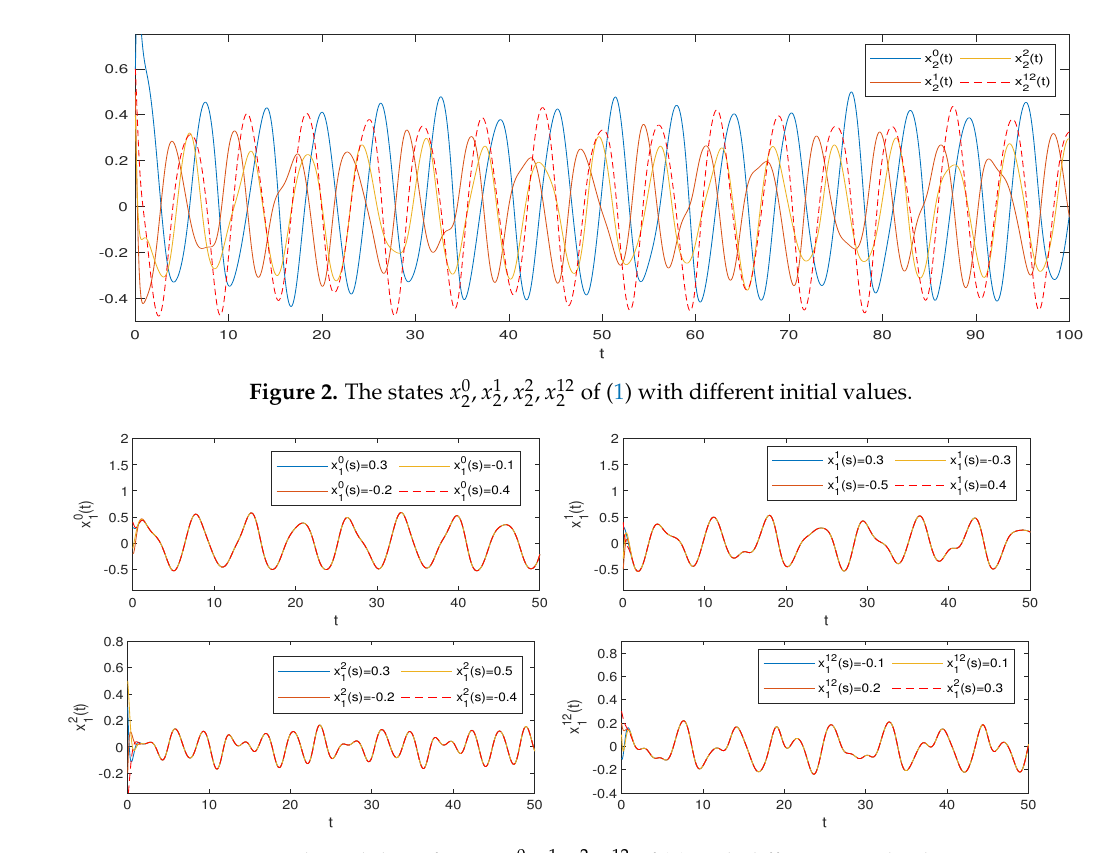
Figure 3. The stability of states x 0